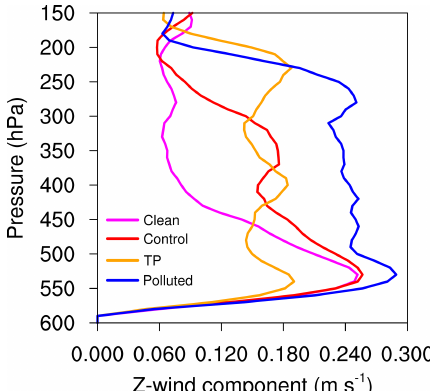
Figure 8. Updrafts in clouds in area A (31.4–31.5 ◦ N, 92.0– 92.1 ◦ E) averaged from 06:00 to 11:00UTC on 24 July 2014, in units of ms − 1